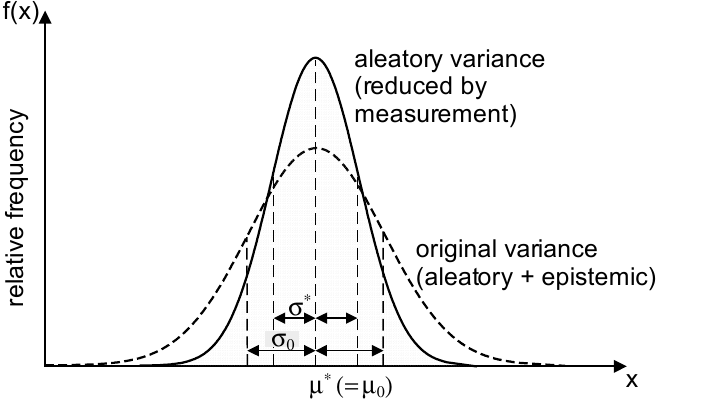
Figure 1. Probability density functions of a variable with original and reduced variance due to increased knowledge.